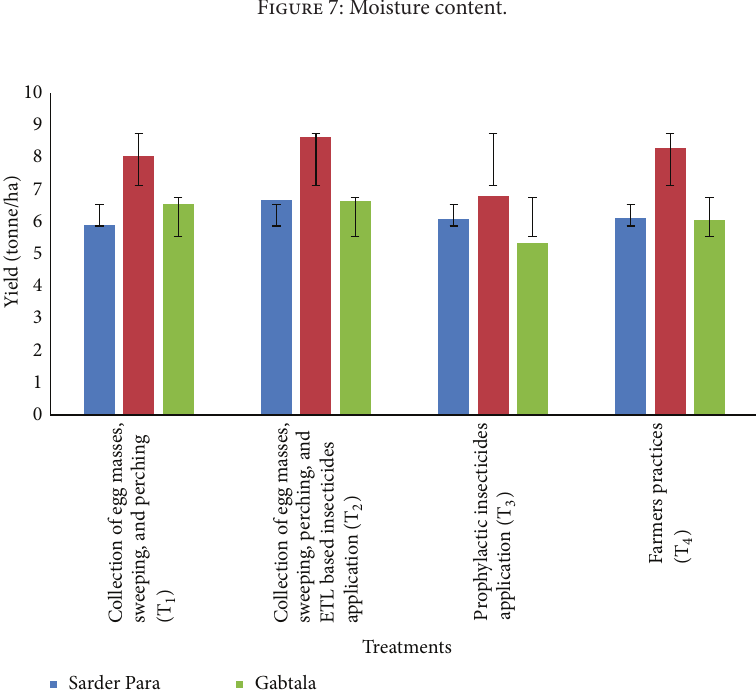
Figure 7: Moisture content.